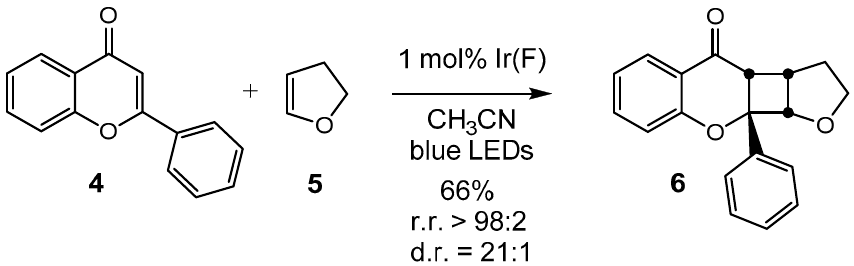
Scheme 2. Energy-transfer sensitized photocycloaddition of flavone with